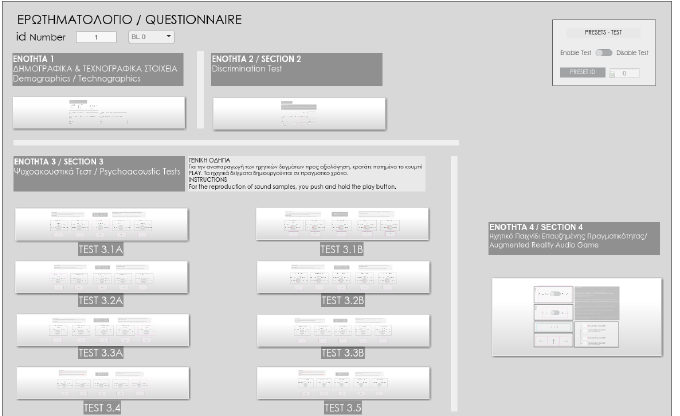
Figure A1. Test start screen.